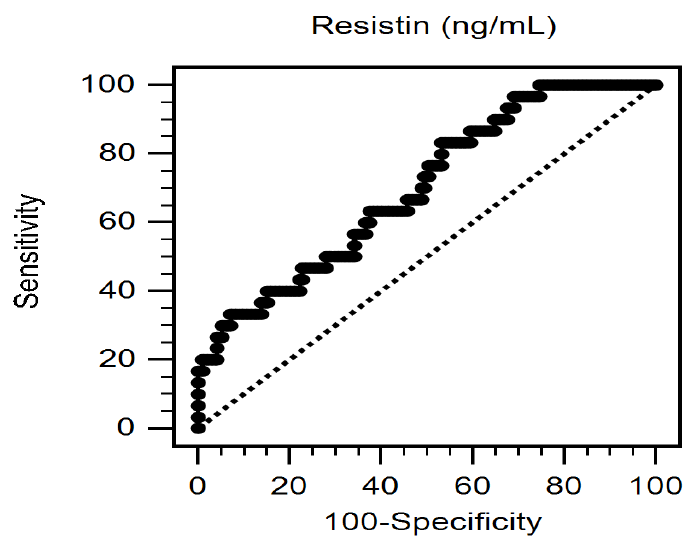
Figure 1. The area under the receiver operating characteristic curve indicates the diagnostic power of serum resistin levels for predicting peripheral arterial disease among 240 chronic kidney disease patients.